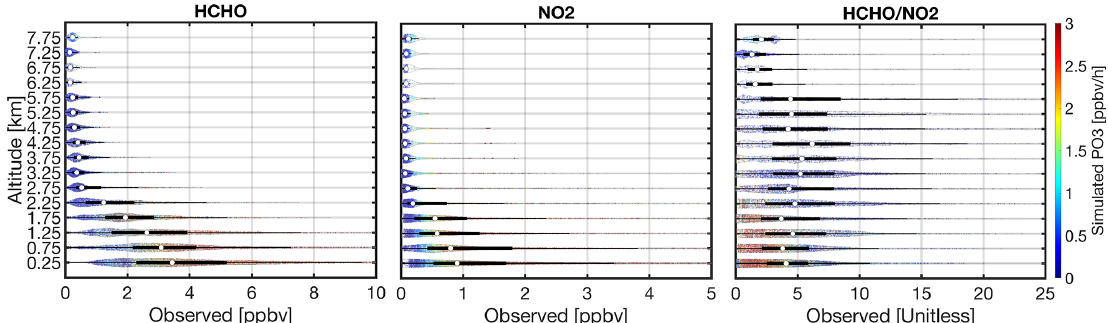
Figure 5. The violin plots of the afternoon vertical distribution of HCHO, NO 2 , and HCHO / NO 2 observations collected during the DISCOVER-AQ Texas, Colorado, Maryland, and KORUS-AQ campaigns. The violin plots demonstrate the distribution of data (i.e., a wider width means a higher frequency). White dots show the median. A solid black line shows both the 25th and 75th percentiles. The heatmap denotes the simulated ozone production